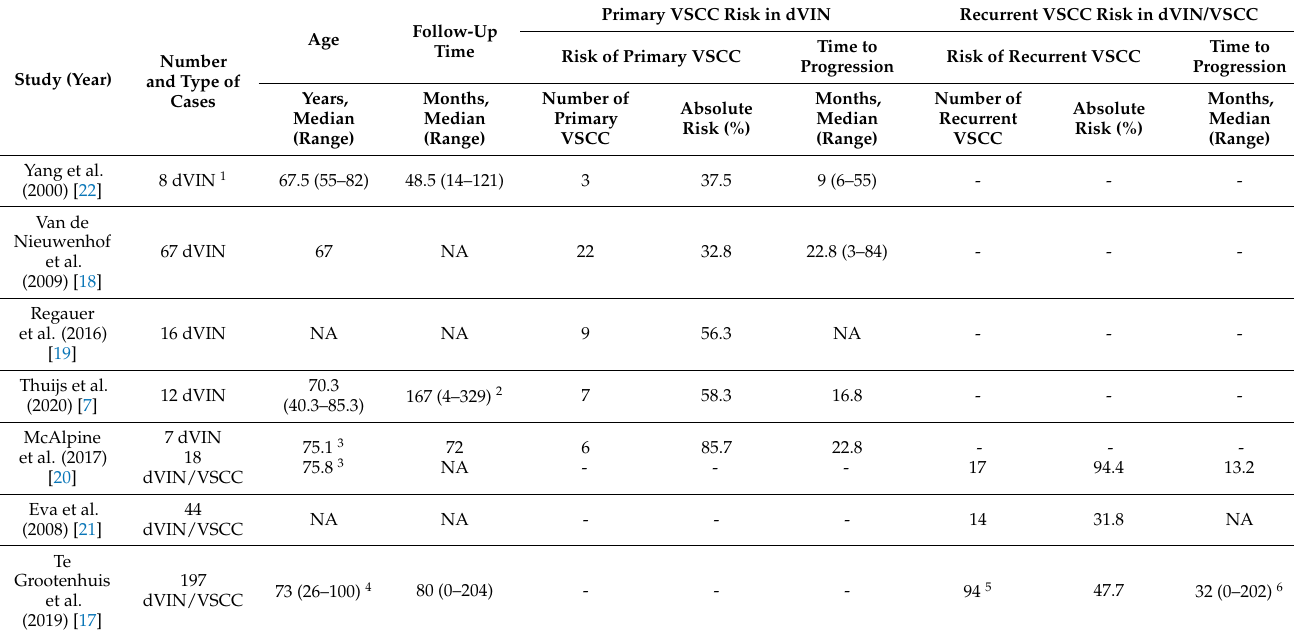
Table 3. Outcome of objectives of all included